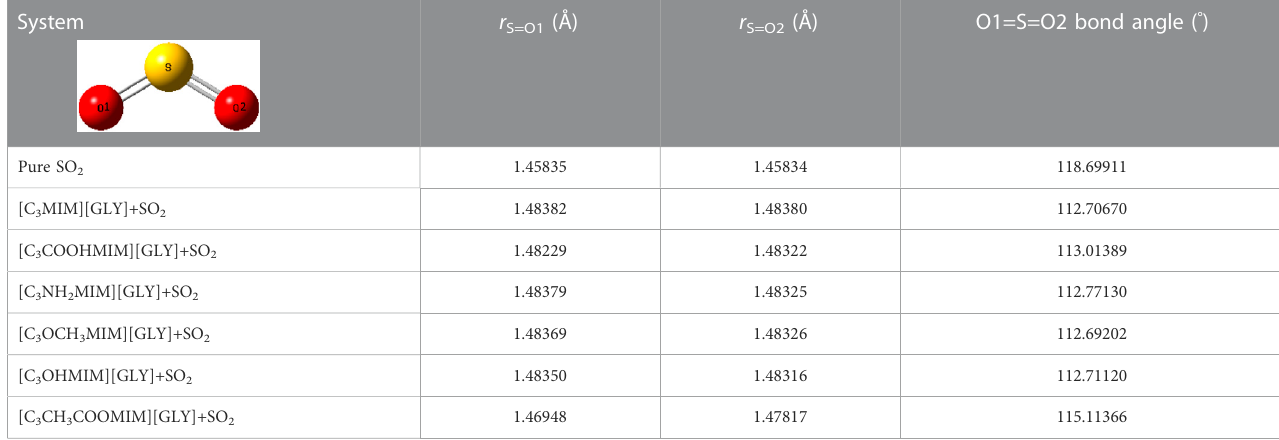
TABLE 2 Structure parameters (S=O bond lengths and the O=S=O bond angle) for SO 2 absorption.